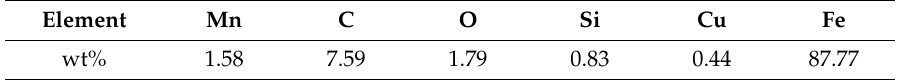
Table 7. Microanalysis of decohesionated external layer observed in Sample 1 (MIG conventional process). Element